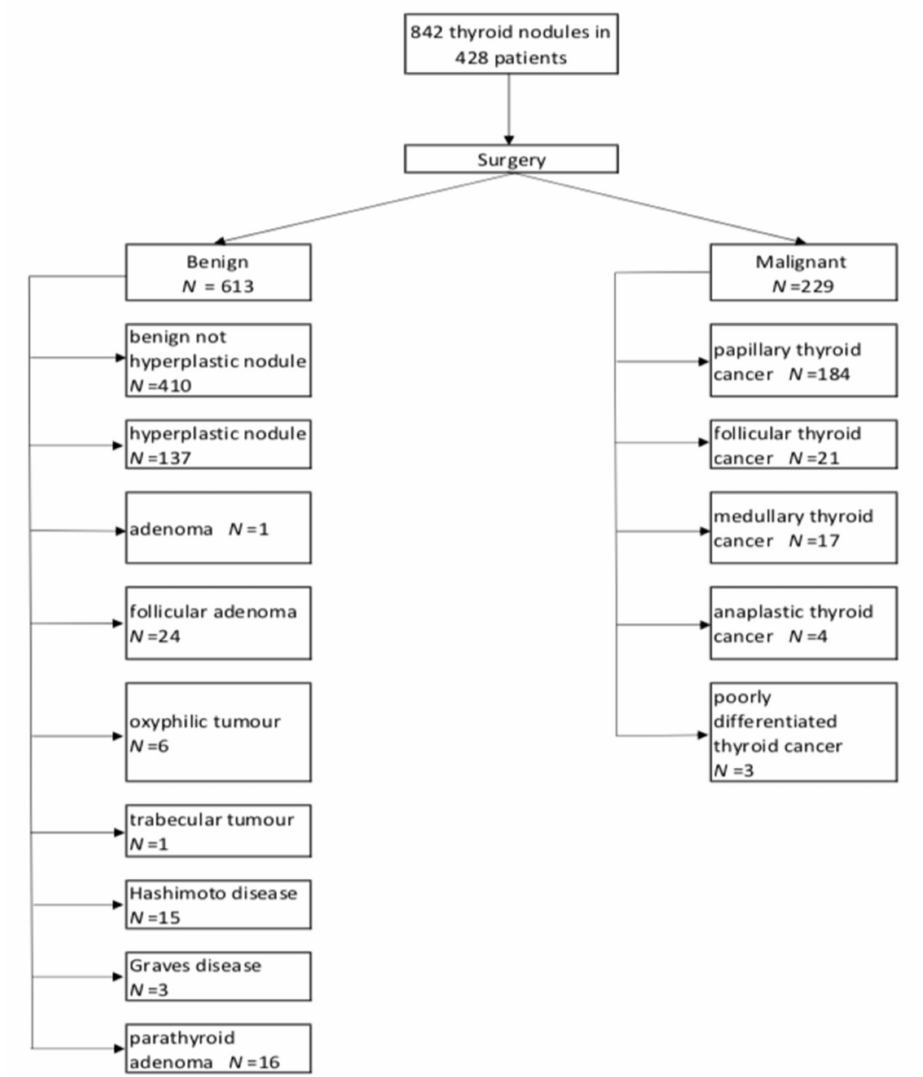
Figure 1. Results of histopathological examination of the thyroid nodules. According to European Thyroid Imaging and Reporting Data System (EU-TIRADS): 154 nodules were EU-TIRADS category 2 (0 lesions were malignant); 93 nodules—EU-TIRADS category 3 (3 / 93, 3% of the lesions were malignant, the area under the curve (AUC) = 0.48); 103 nodules—EU-TIRADS category 4 (12 / 103, 19% of the lesions were malignant, AUC = 0.40), 492 nodules—EU-TIRADS category 5 (214 / 492, 43% of the lesions were malignant, AUC = 0.42). The ROC curves (Figure 2) show true positive rates versus false positive rates corresponding to di ff erent size thresholds (in mm) to perform